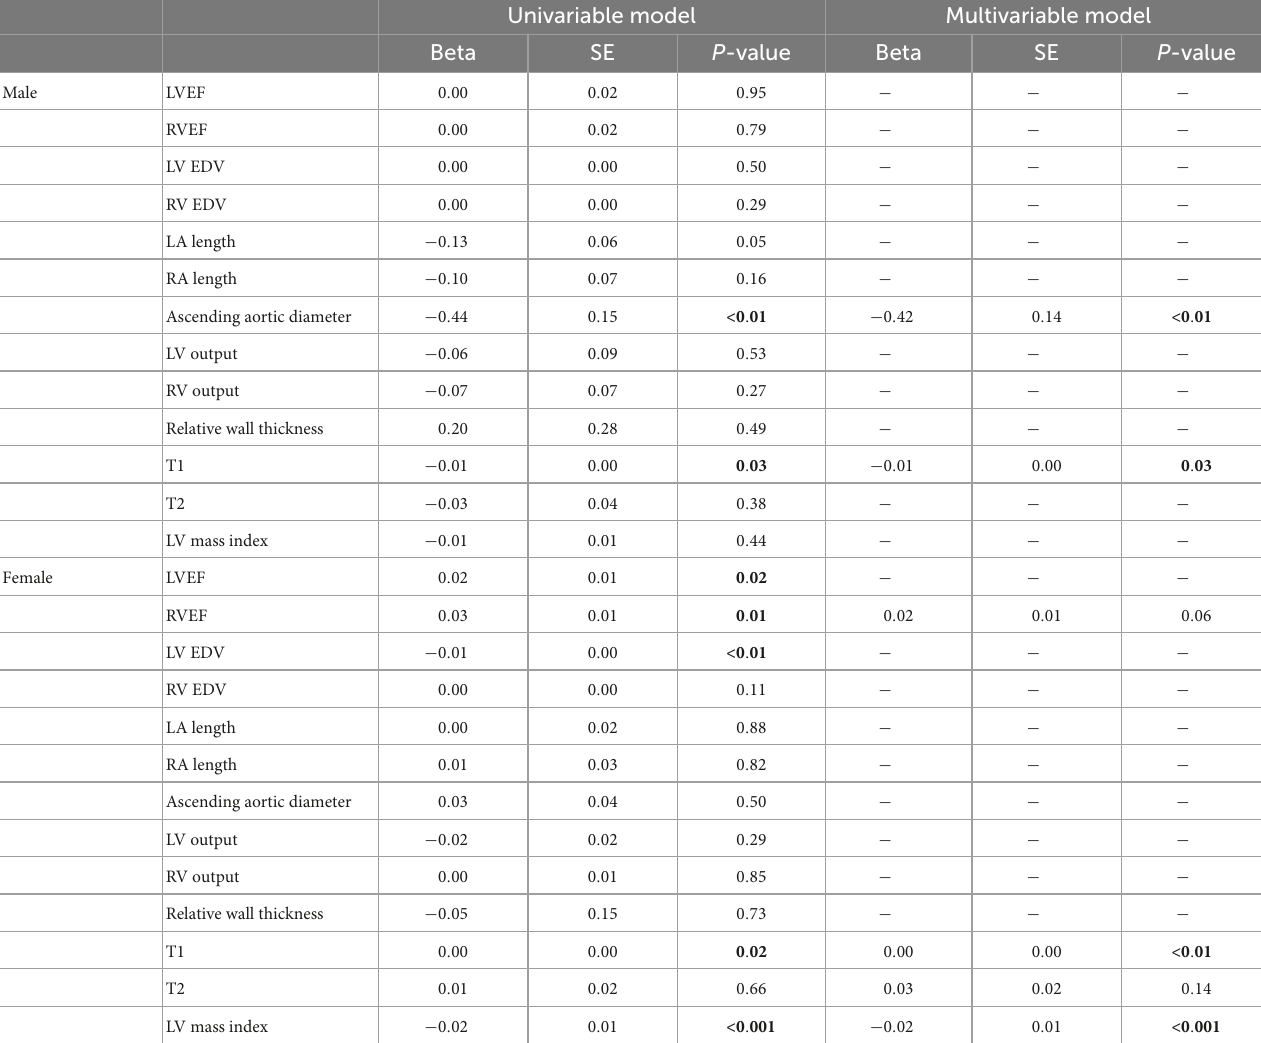
TABLE 3 Associations of cardiac structure and function measures and the myocardial perfusion reserve index (MPRI). Univariable model Multivariable